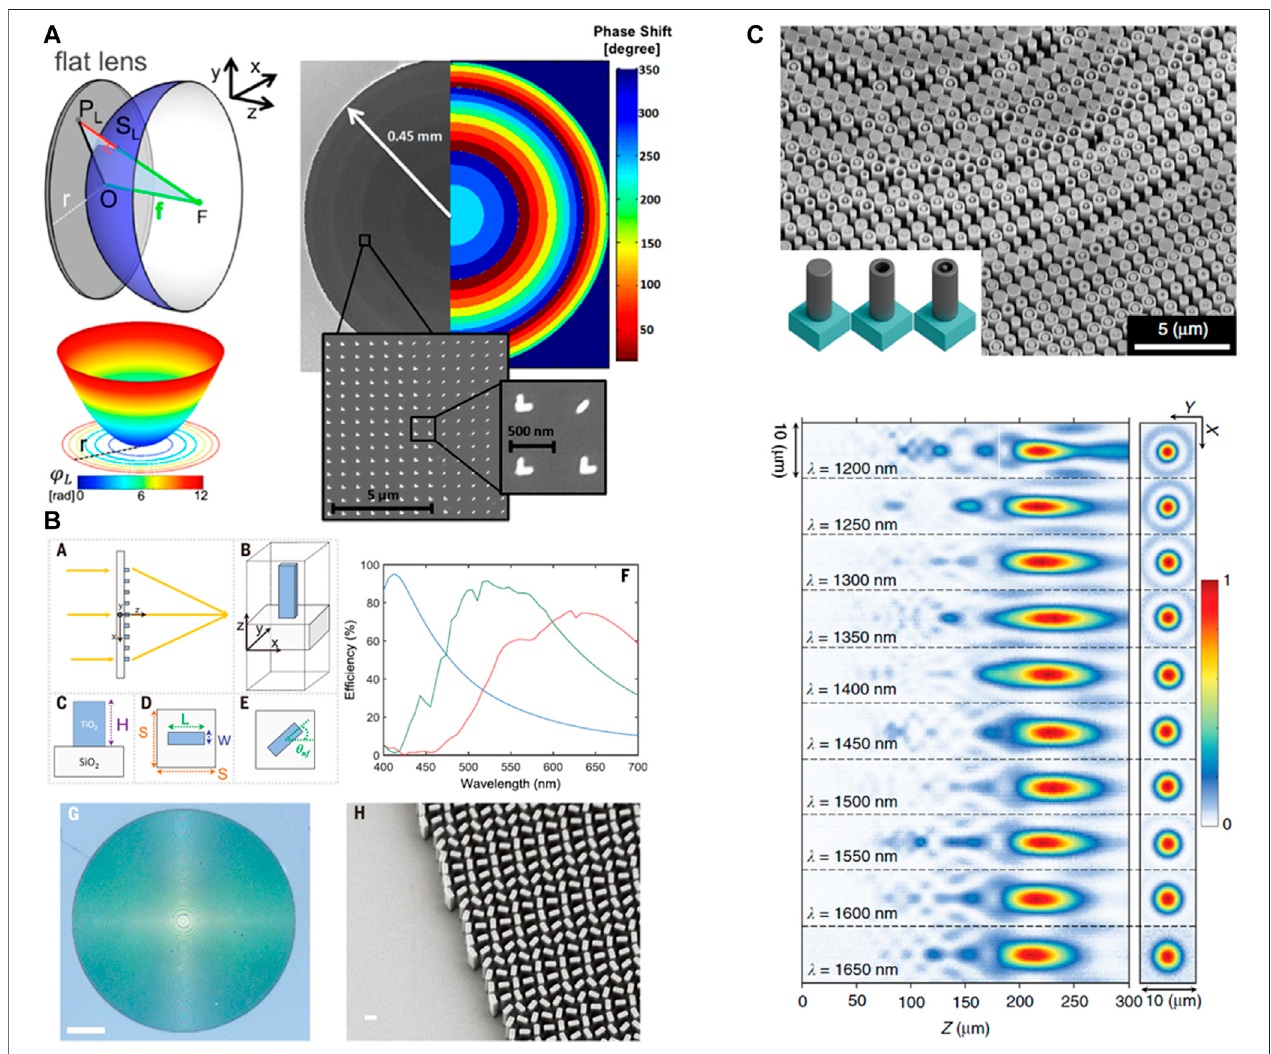
FIGURE3 |(A) Design schematic diagram ofphase distribution ofmetalens aswell asmetallicmetalens consists ofV-shaped nanoantennas withdifferentlengths andopeninganglesofplasmonicnanorods[2]. (B) Dielectricmetalensconsistsofhigh-aspect-ratiotitaniumdioxide(TiO2)nanobrickswithdifferentorientations[72]. (C) Dielectric metalens working in a large wavelength range (1,200 – 1,650 nm) with super meta-atoms composed of multi-resonators [137]. Figure reproduced with permission from: (A) , © 2012, American Chemical Society (ACS); (B) , © 2016, American Association for the Advancement of Science (AAAS); (C) , © 2018, Nature Publishing Group